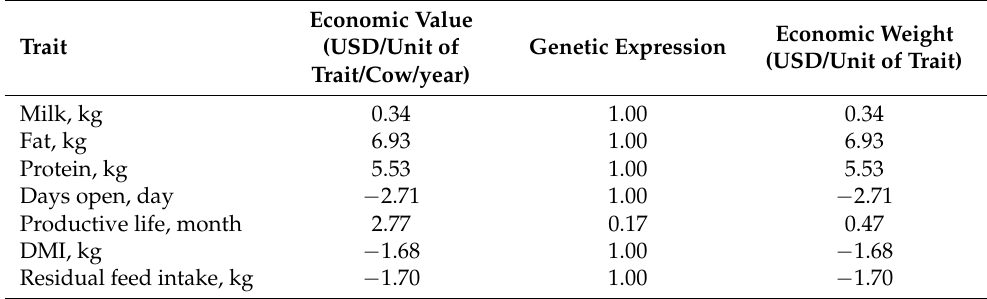
Table 5. Economic values, genetic expressions, and estimated economic weights for each breeding objective trait.